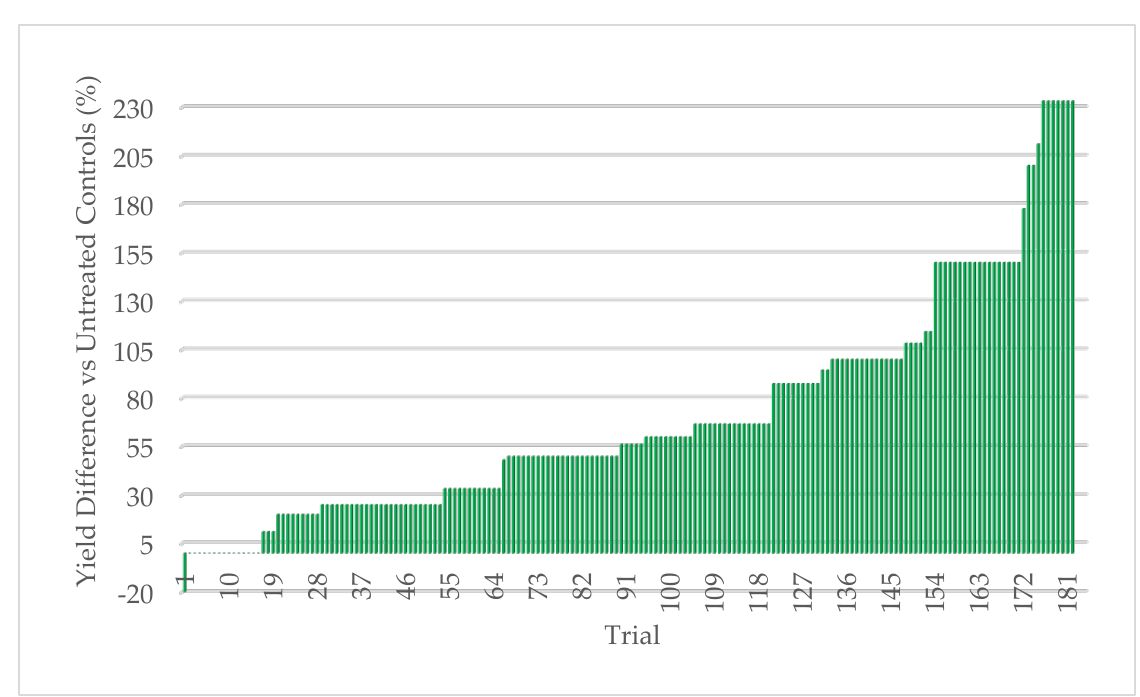
Figure 11. Pearl millet response to BioEnsure. 106 trials (0.1 – 5.0 acres/plot) were performed with carry-over and market seed. Each bar represents a separate comparative trial of treated (ThMS3a) vs untreated plant yields. Win rate was 96% with a minimum of 10% yield increase. Each test had a single replication of treated and untreated so it was not possible to include standard deviations or statistical analysis. Cooperators: farmers.